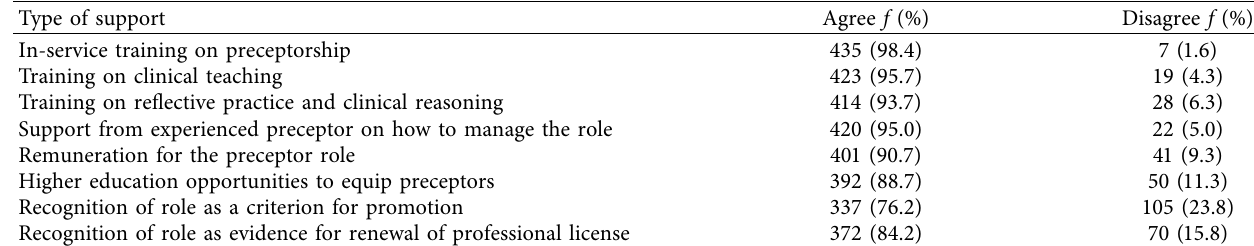
Table 6: Support preceptors need to successfully perform their roles N �